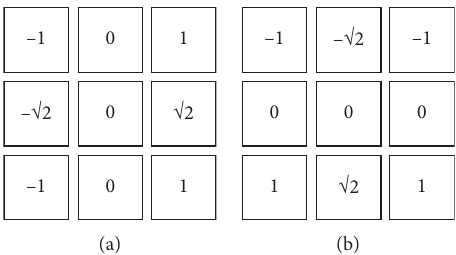
Figure 1: The directional templates of isotropic sobel operator. (a) Horizontal gradient direction. (b) Vertical gradient